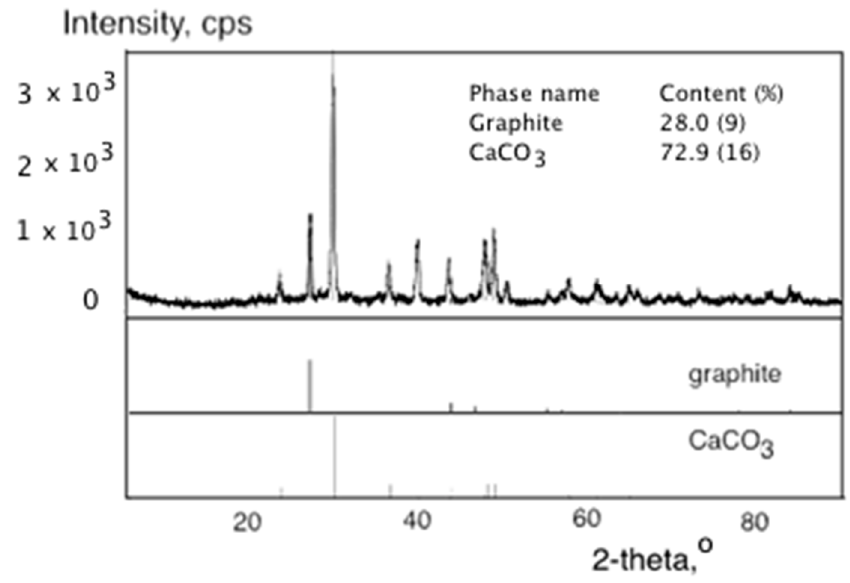
Figure 4. XRD diagram of the black part of the fresco with Rietveld processing.